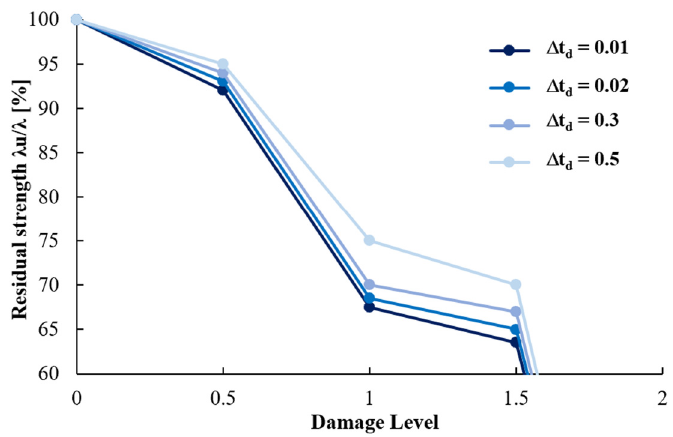
Figure 13. Robustness curves for 2D RC frame structure for location 2: effect of variation of ∆ t d (removal time of the column). ∆ t d values are expressed in seconds.